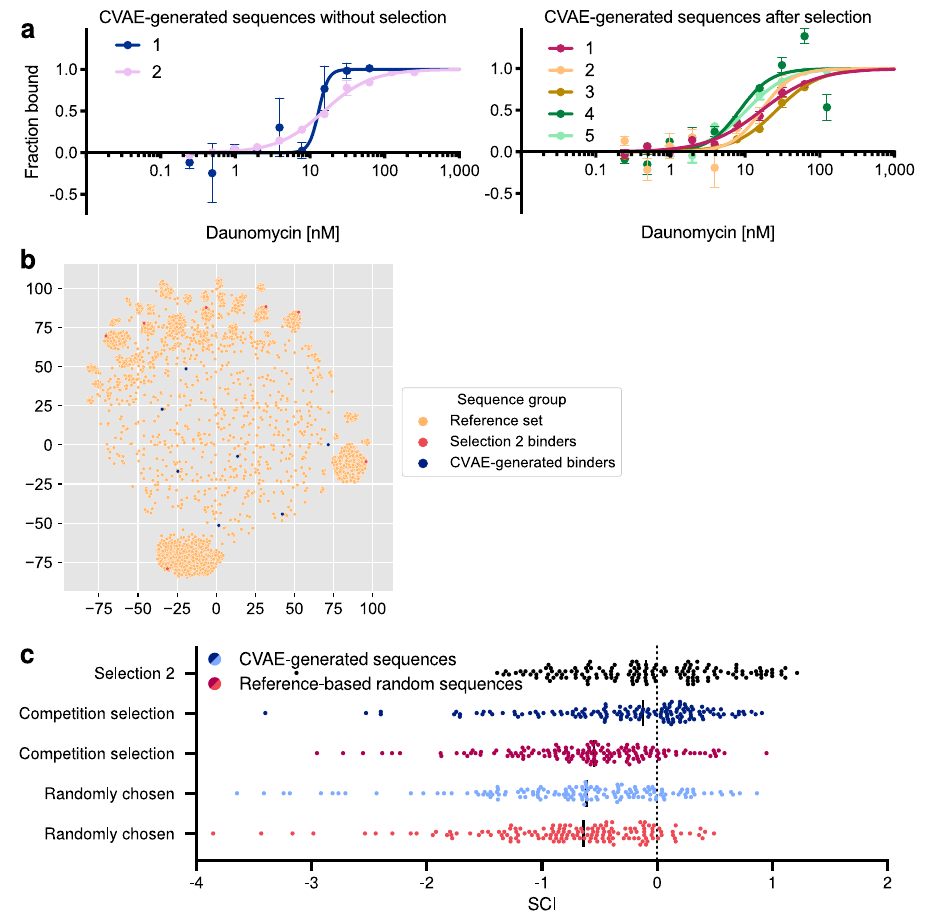
Fig. 5 | CVAE-generated sequences bind potently to daunomycin yet are unrelated to experimental sequences. a MST characterization of the binding af fi nity of CVAE-generateddaunomycin-binding HFNAPsidenti fi ed directlyor with a single round of high-stringency selection. Sequences were found to bind with K d =13 – 15nM and K d =9 – 26nM respectively. Values and error bars re fl ect mean andSEMfor n =3independentreplicates. b UMAPprojection(anon-linearmethod of dimensionality reduction) of reference set sequences, selection 2 daunomycin- binding HFNAP sequences, and CVAE-generated daunomycin-binding HFNAP sequences. 3072 reference-based random sequences and 3072 truly random sequences were included in the distance matrix and embedding but omitted from the fi nal UMAP plot for clarity. Reference set sequences form clusters, indicating sequence similarity. Selection 2 daunomycin-binding HFNAPs, which are sequence related to the reference set, are found within these clusters. The selection 2 daunomycin-bindingHFNAPsusedwereDm-HS-1,2,3,6,7,8,and10.Dm-HS-4and Dm-HS-5 were omitted for sequence similarity to Dm-HS-1, and Dm-HS-9